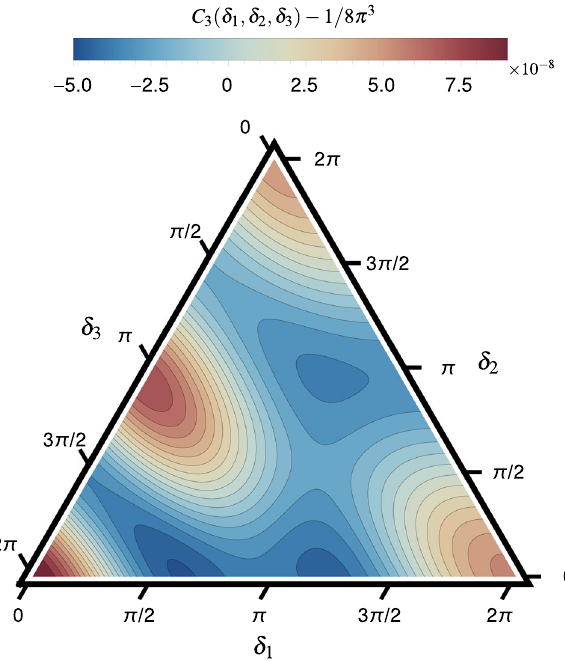
Fig. 6 Dalitz-like plot of the “unit-cell” (black triangle in Fig. 5) of genuine three-particle correlation